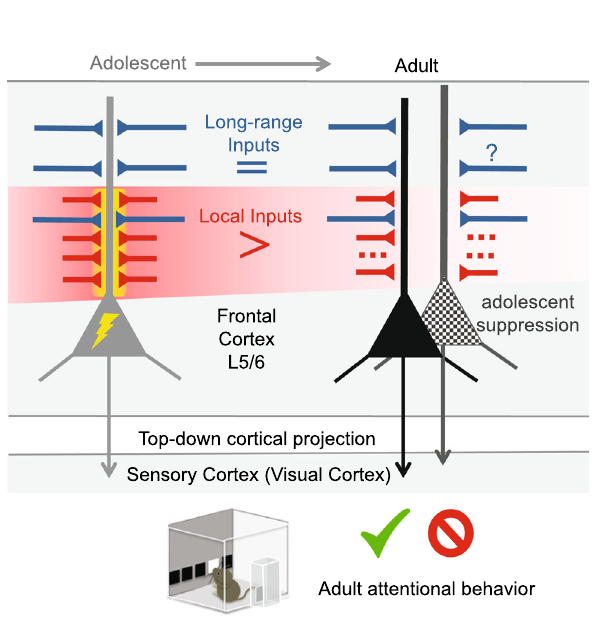
Fig. 7 Summary: adolescent period of top-down circuit maturation. Frontal top-down ACA VIS projection neurons receive heightened local excitatory inputs (red) and show greater activity (yellow lightning bolt) during adolescence compared to adulthood, while long-range inputs (blue) are already established prior to adolescence. These developmental changes lead to a shift in the balance of local/long-range input on ACAvis neurons between adolescence and adulthood. Chemogenetic perturbation of top- down activity during this adolescent window of heightened excitatory and local connectivity results in failed maintenance of local connectivity and attentional de fi cits in adults (top-down neuron underwent adolescent silencing is labeled with black